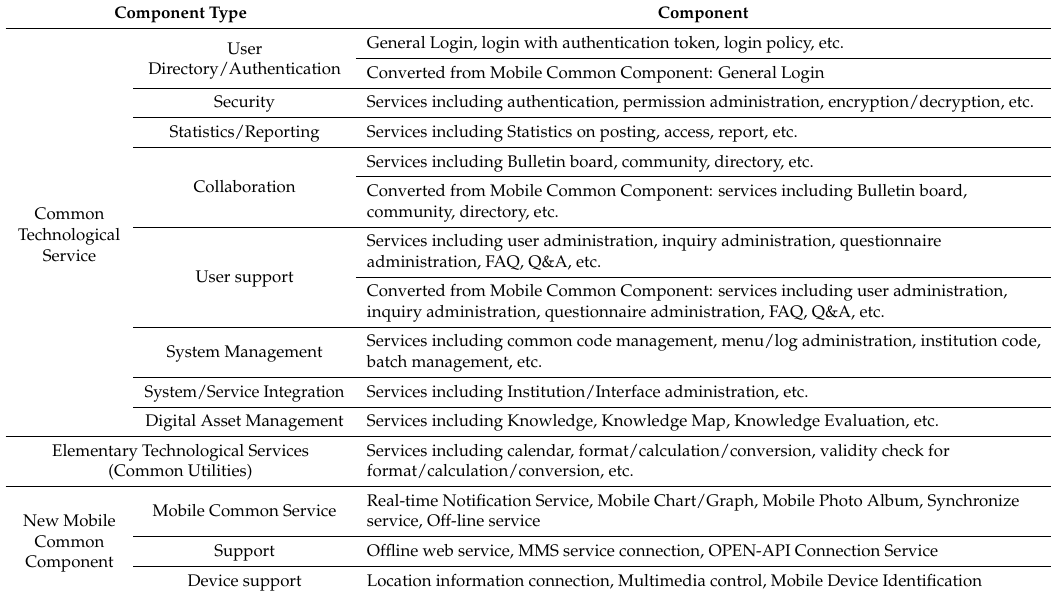
Table 1. South Korean e-Government Standard Framework (eGovframework) component